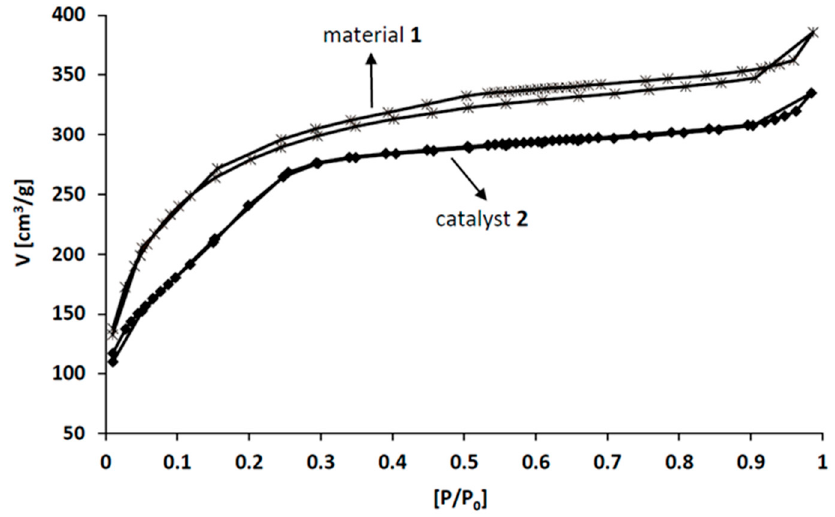
Figure 2. N 2 adsorption/desorption isotherms of material 1 and catalyst 2 .